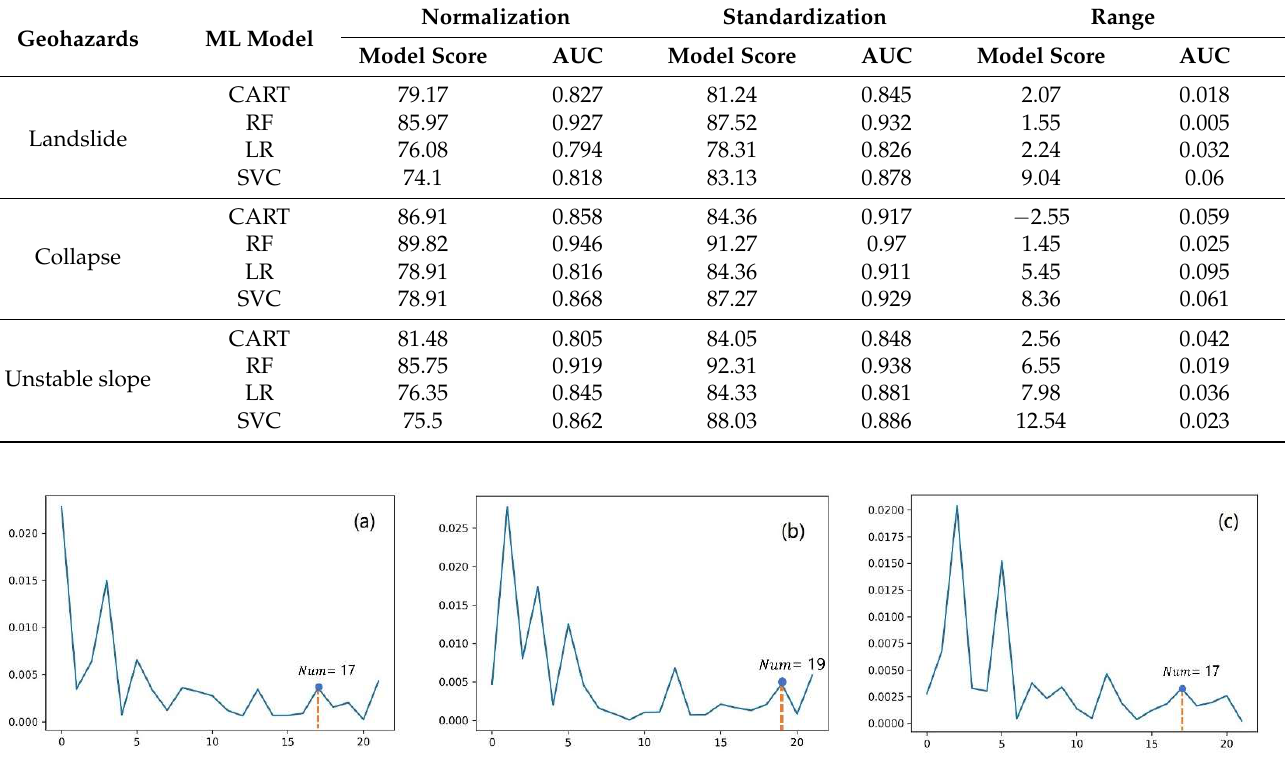
Figure 6. Difference of feature importance by ranking order. X-axis refers to the feature numbers, while the Y-axis is the D GI : ( a ) Landslide; ( b ) Collapse; ( c ) Unstable slope. After repeated experiments, the last peak always appeared in the range of 16~20 (fea- ture numbers), indicating that when the remaining features are appropriately 70% (i.e., 17 features) remaining, the GI is relatively low and will not vary dramatically. Therefore, 70% (i.e., 17 features) was finally selected as the threshold.